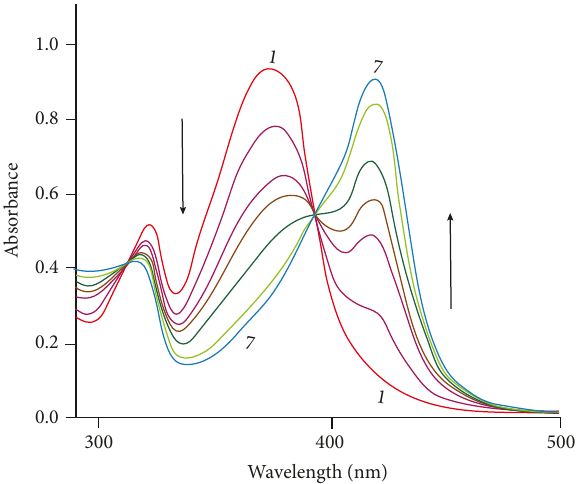
Figure 7: Electronic absorption spectra of 4 in acetonitrile ( 3 0 · 10 − 5 M ) before ( 1 ) and after addition of CF M ( 2 ), 2 · 10 − 4 M ( 3 ), 3 · 10 − 4 M ( 4 ), 5 · 10 − 4 M ( 5 ), 1 0 · 10 − 3 M ( 6 ), and 1 5 · 10 − 3 M ( 7